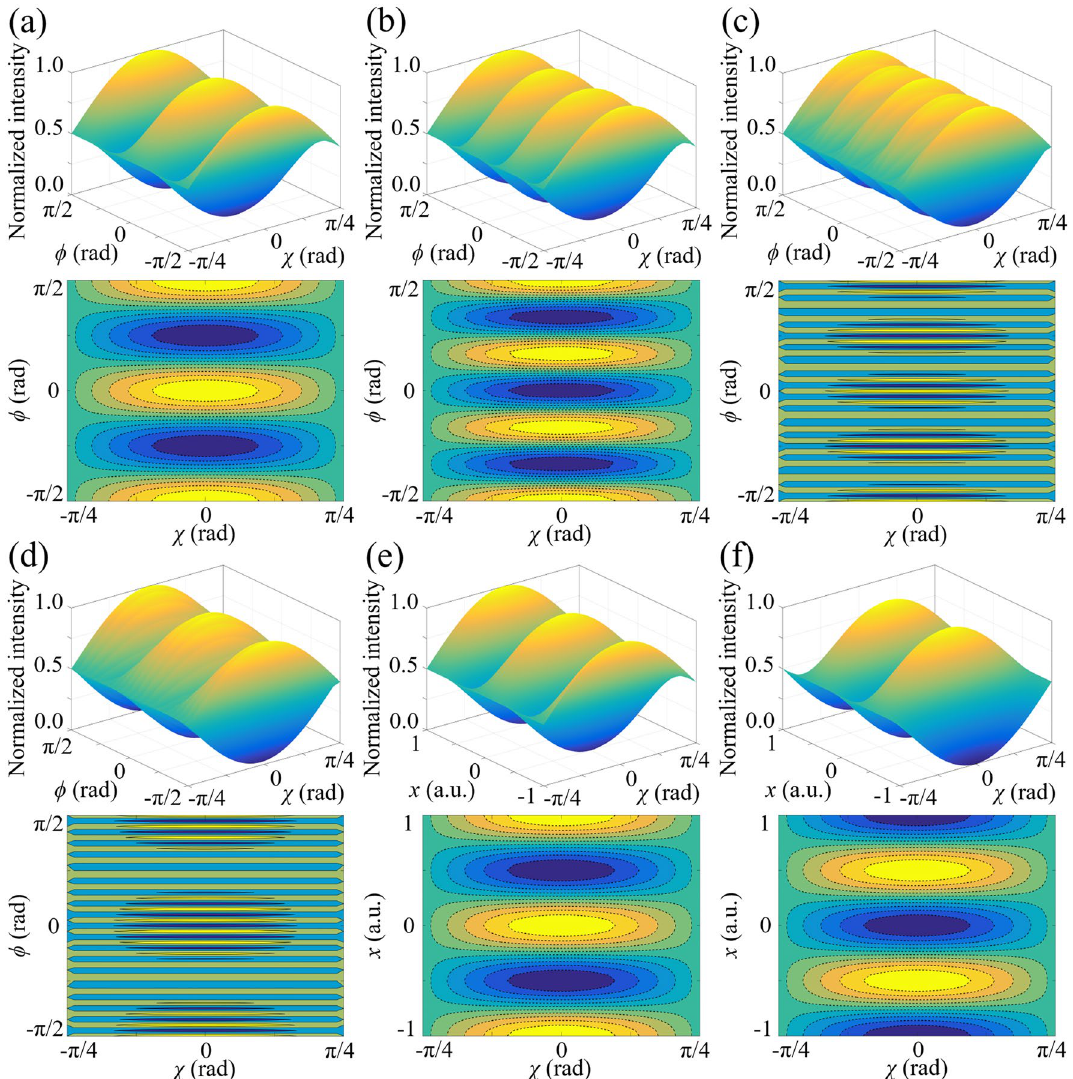
Figure 2. Changing behaviors of interference light intensities along the azimuthal direction when χ of photons varies between − π/4 and π/4 in terms of the OAM states of ( a ) m = 2, ( b ) m = 3, ( c ) m = 18 and ( d ) m = 19. The light intensities along x -axis ( r cos ϕ ) are controlled to change sinusoidally by the SAM magnitude when the topological charges are ( e ) even and ( f ) odd, regardless of the value of OAM. Contour maps are presented below each three-dimensional